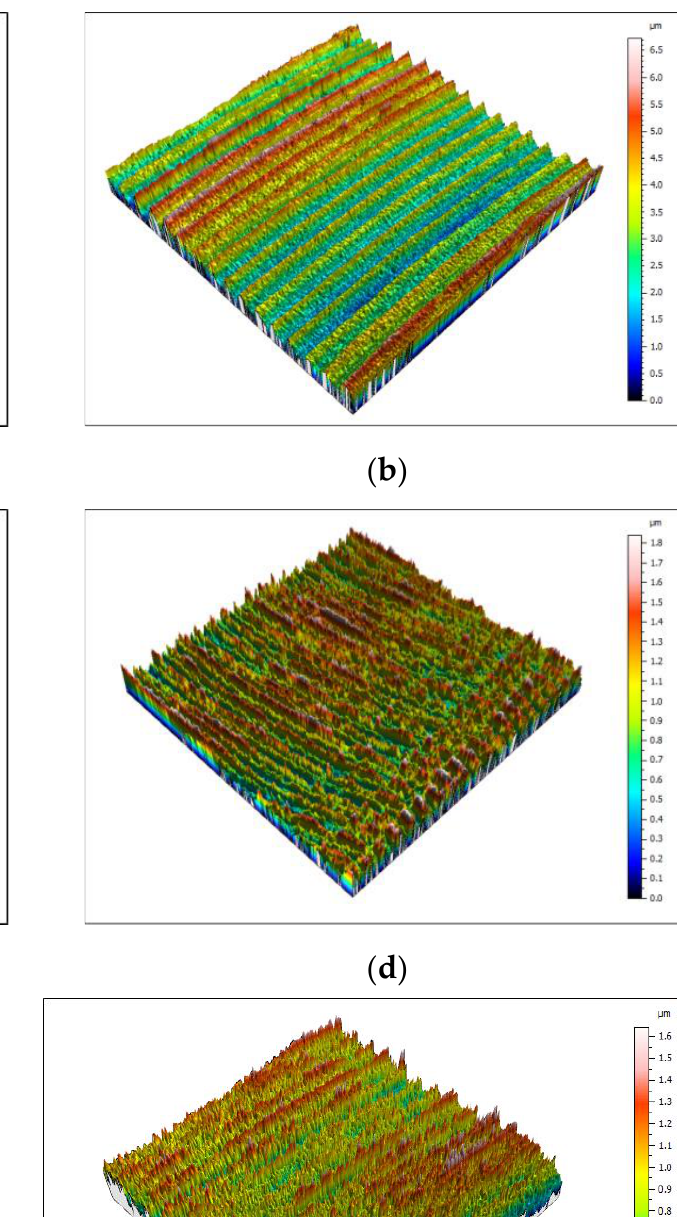
( f ) Figure 6. Contour map and isometric view of samples. ( a , b ) Coded A, ( c , d ) coded B, ( e , f ) coded C. The code group D was characterized by surface parameters with the following val- ues: Sq = 1.54 µm, Ssk = −0 .322 µm, Sku = 2.45 µm, Sp = 3.96 µm, Sv = 2.76 µm, Sz = 6.72 µm, Sa = 1.25 µm, Spd = 331 1/mm 2 , and Spc = 8454 1/mm. The sample surface was gener- ated by turning on a numerical lathe with the feed parameters f = 0.1 mm/rev and the cutting speed vc ≈ 100 m /min. For the surface of the samples belonging to the group in question, a contour map, and an isometric view, presented in Figure 7, were created. The samples belonging to code group E are characterized by surface parameters with the fol-